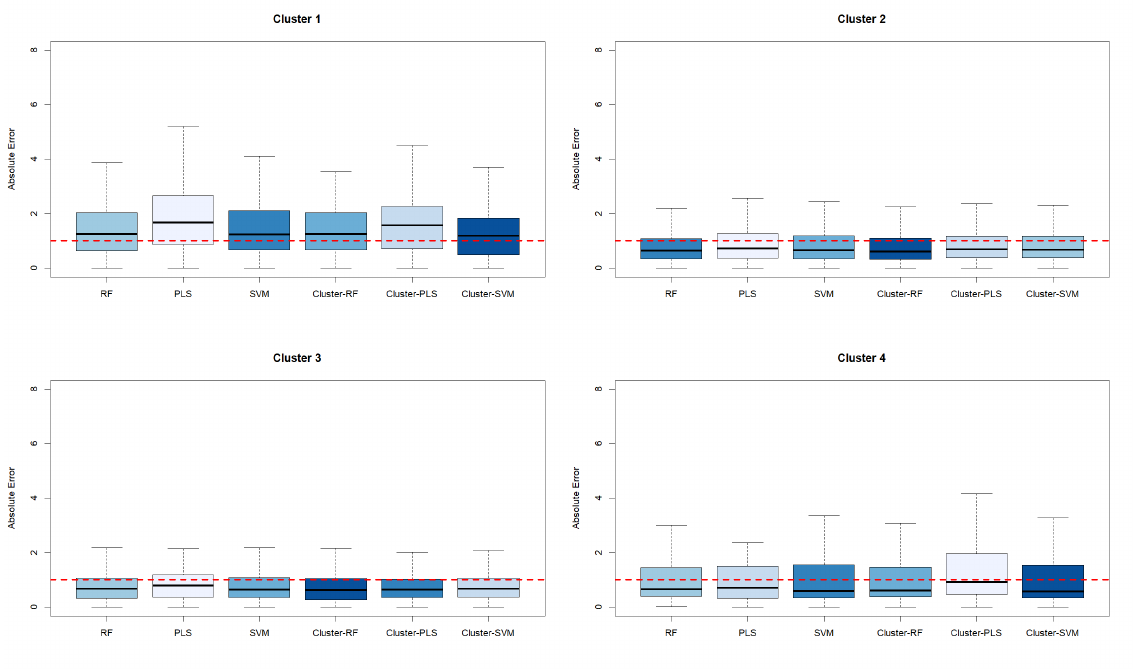
Figure 4 - Performances of the different methods (RF: random forest, PLS: partial least squares, SVM: support vector machines) in terms of the log of the absolute error of the CF ET with respect to the different clusters for 200 repetitions. In each cluster, the models are coloured from dark blue (best) to clear blue (worst) according to their median of the absolute error. The red dotted line represents an absolute error of 1 log that is considered as acceptable (Rosebaum et al. 2008 ; Douziech et al.,